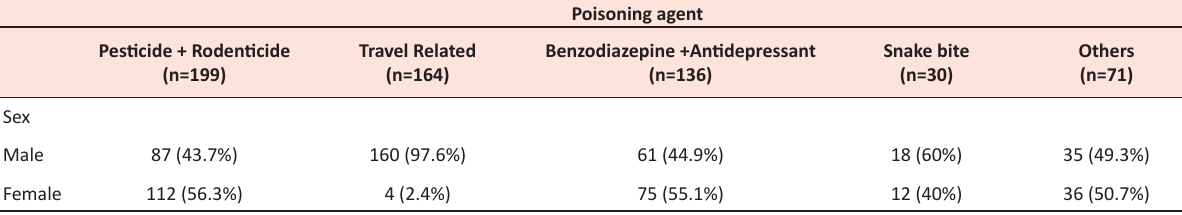
Table 5. Association between sex and poisoning agent (n =